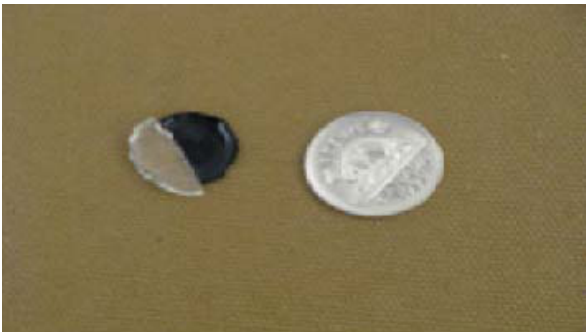
Figure 8. Thermally set polymer along with the ceramic.